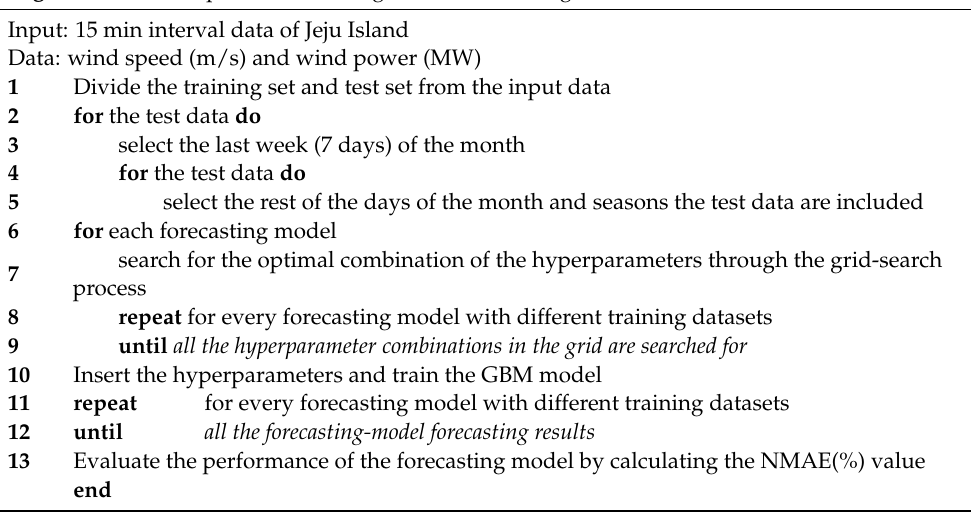
Algorithm 1: Wind-power forecasting based on GBM algorithm